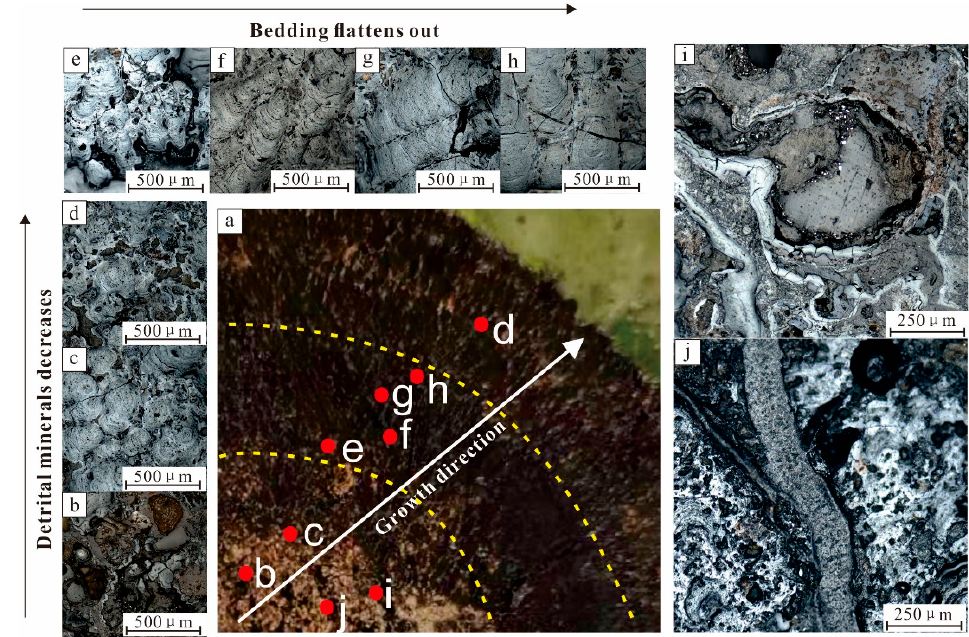
Figure 3. Microstructural characteristics of polymetallic nodule crust. ( a ) growth direction of the polymetallic nodule; ( b ) mottled structure; ( c ) oncentric spherical structure; ( d ) laminated structure; ( e ) columnar structure; ( f ) stronmatolitic structure; ( g ) massive structure; ( h ) petal-shaped structure; ( i ) vein-like structure; ( j ) filling-like structure. The yellow dotted line is the boundary between the loose and dense layers. ( b , c ) are in the loose core; d is in the loose shell; ( e – h ) are in dense shell; ( i , j ) are the secondary structure in the loose core.